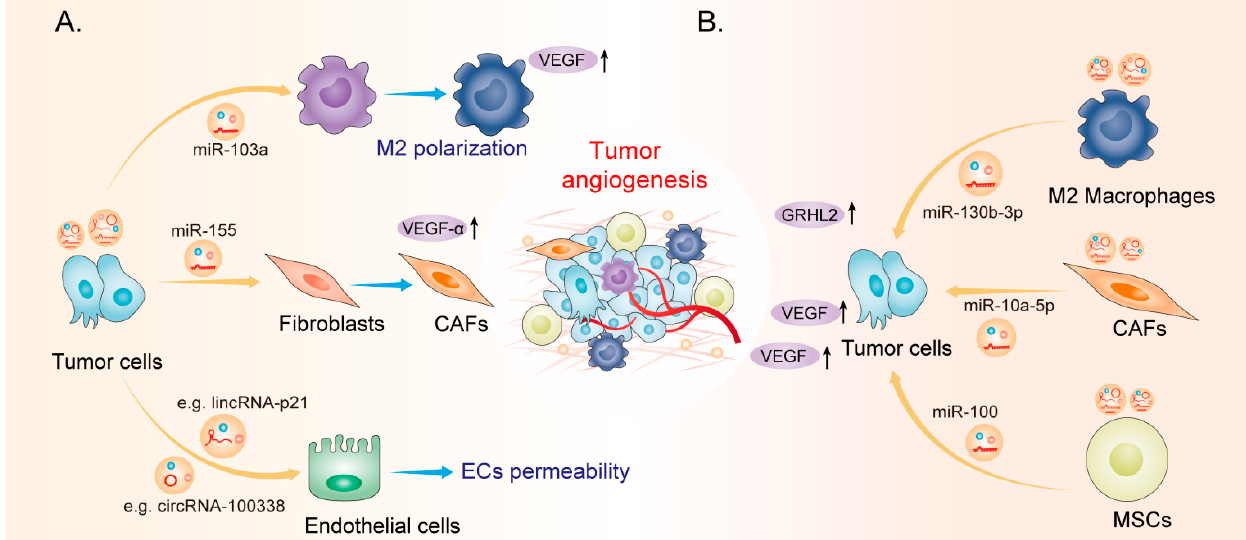
Figure 2. EV-derived ncRNAs regulate cell–cell communication in the angiogenic microenviron- ment. Tumor cells ( A ), immune cells, and stromal cells ( B ) release EVs containing miRNAs, lncRNAs, circRNAs, and piRNAs, contributing to tumor angiogenesis within the tumor microenvi- ronment. ECs: endothelial cells, CAFs: cancer-associated fibroblasts, and MSCs: mesenchymal stro- mal